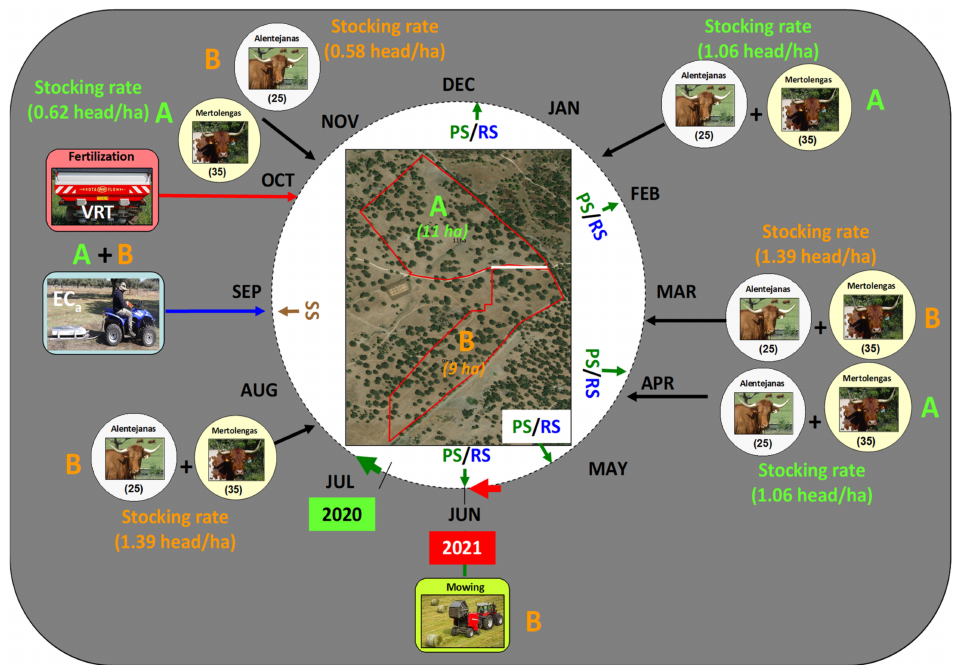
Figure 4. Schematic representation of “A” and “B” field management between July 2020 and June 2021.VRT, variable rate technology; EC a , soil apparent electrical conductivity; SS, soil sampling; PS, pasture sampling; RS, remote sensing.